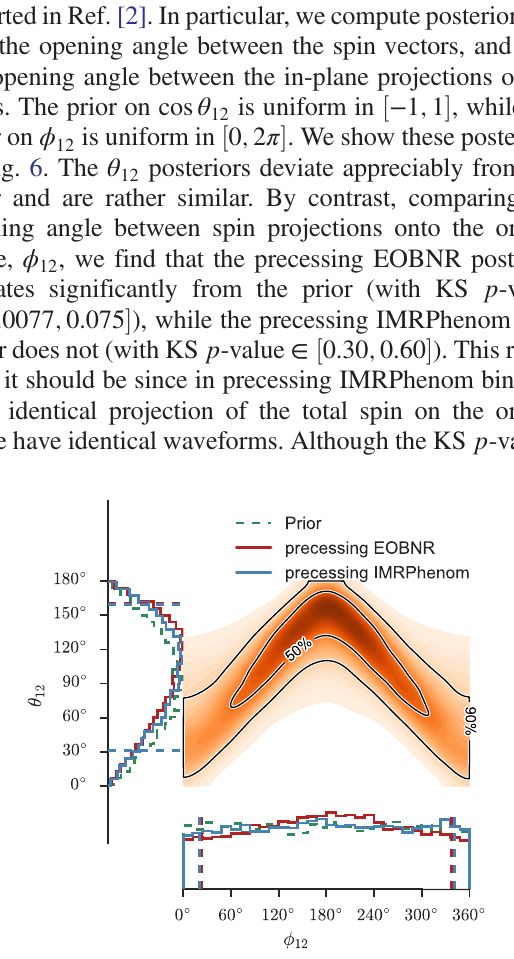
FIG. 5. Posterior probability densities of the effective spin and perpendicular effective spin. (See Fig. 2 for details.)